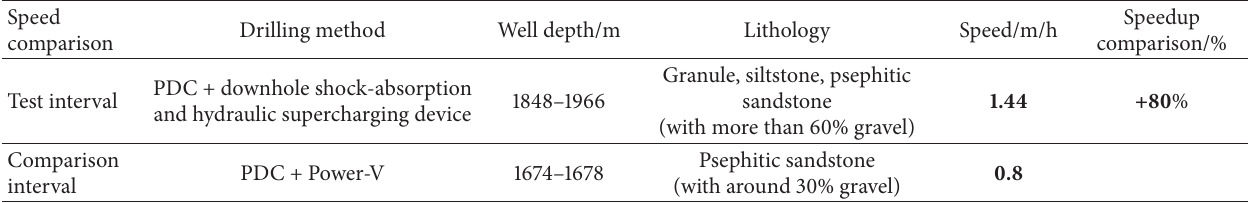
Table 3: Comparison of speeds into siltstone in adjacent well intervals.